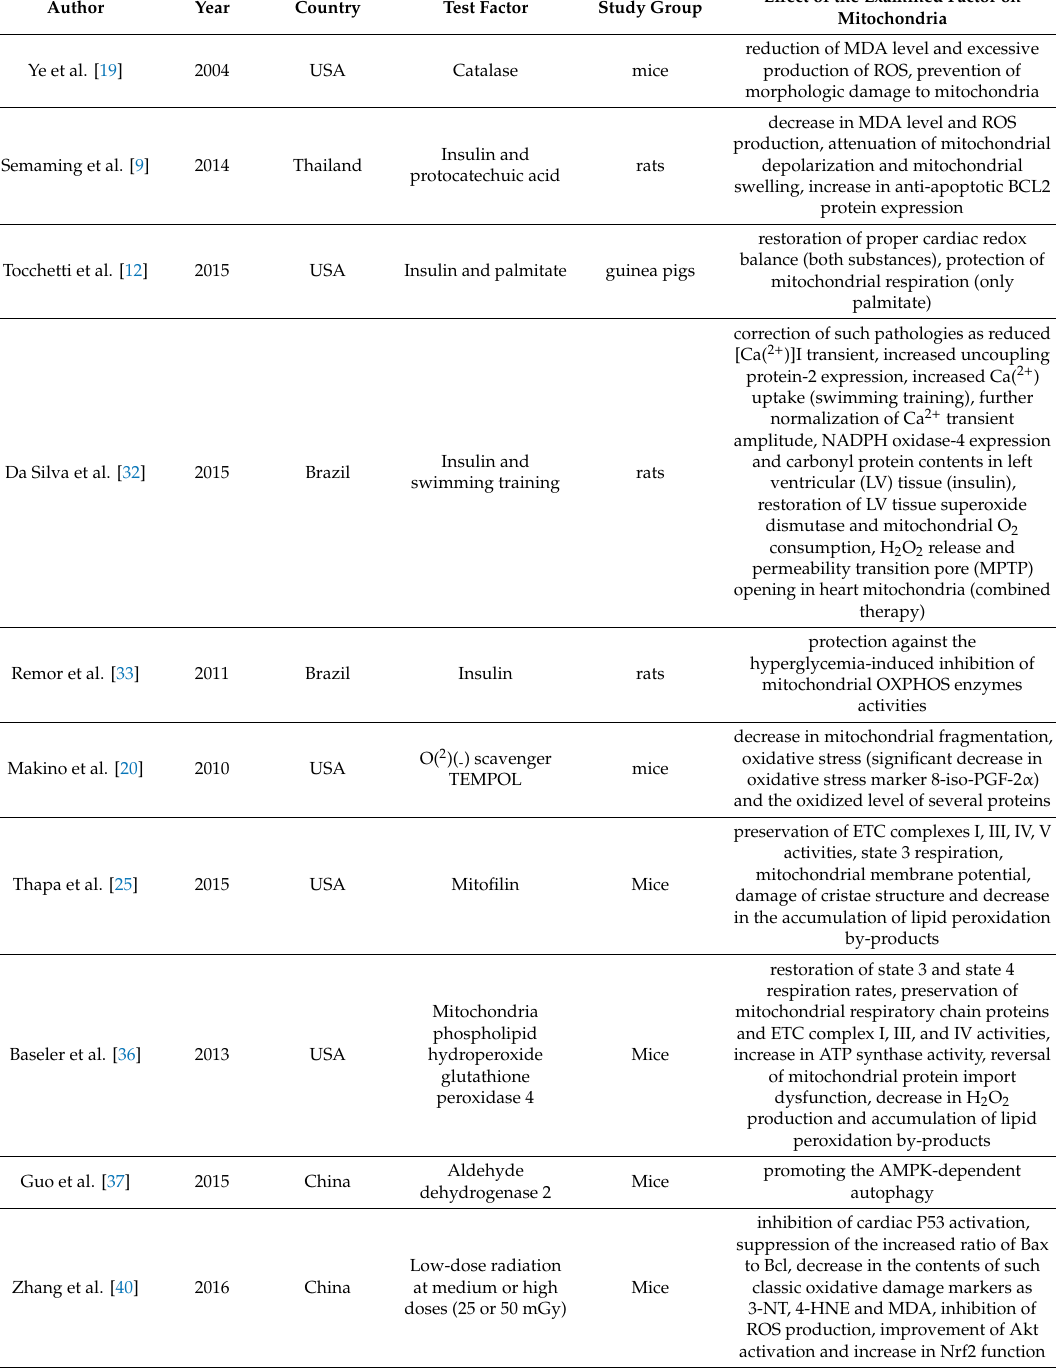
Table 2. Options of treatment of adverse changes induced by hyperglycemia in cardiac mitochondria in type 1 diabetes